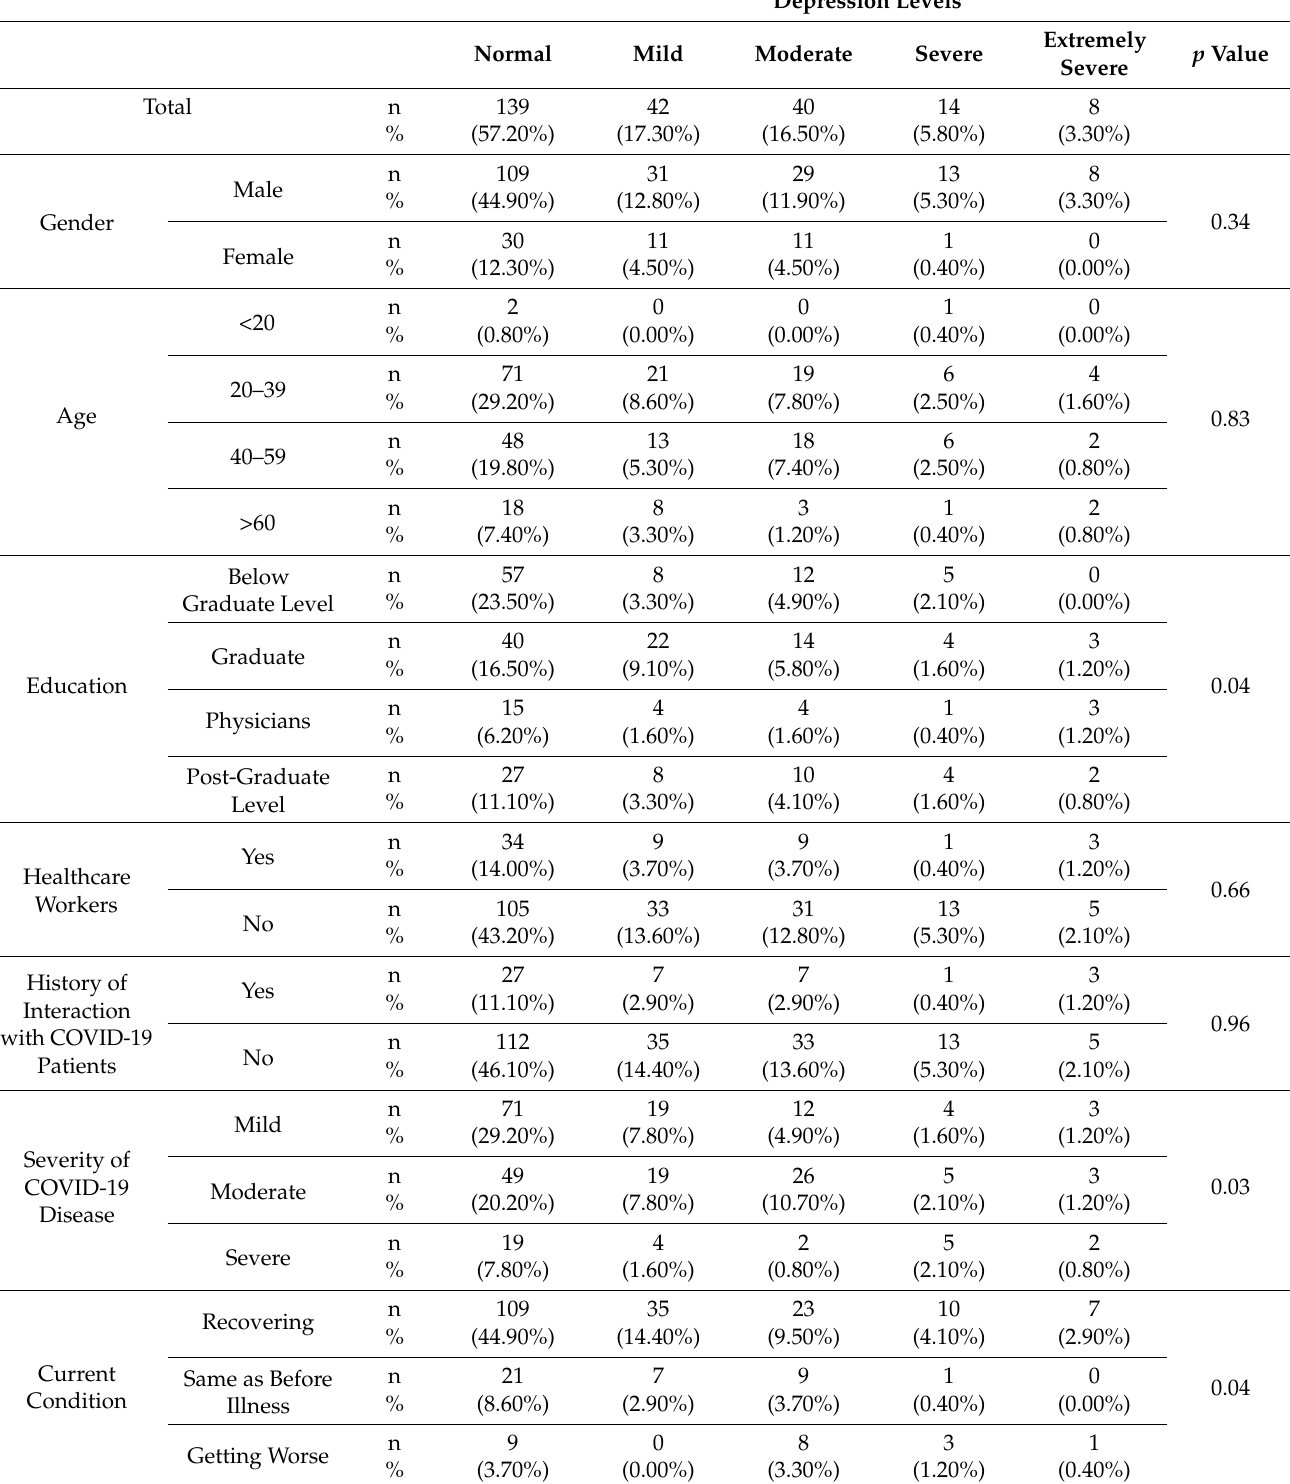
Table 2. Percentage distribution of demographics and depression